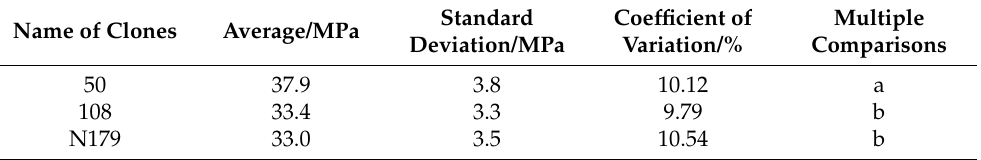
Table 5. Statistical results of the compressive strength parallel to grains in three poplar